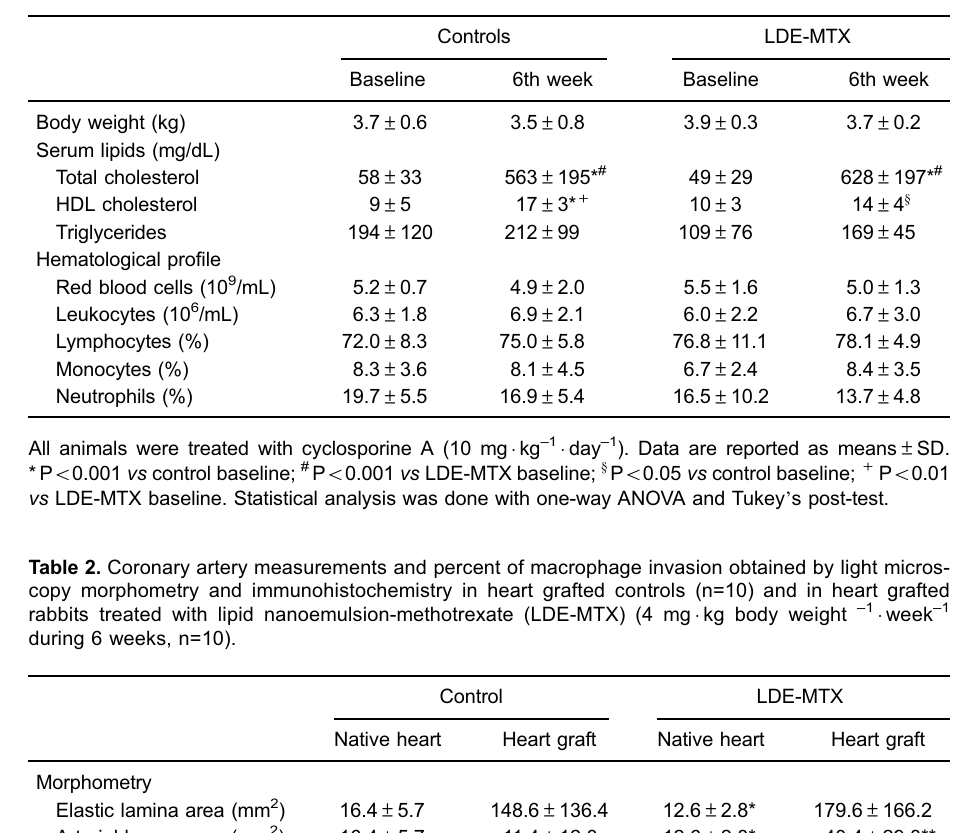
Table 1. Body weight, serum lipids and hematological pro fi le of heart grafted controls (n=10) and heart grafted rabbits treated with lipid nanoemulsion-methotrexate (LDE-MTX) (4 mg (cid:1) kg body weight – 1 (cid:1) week – 1 during 6 weeks, n=10).